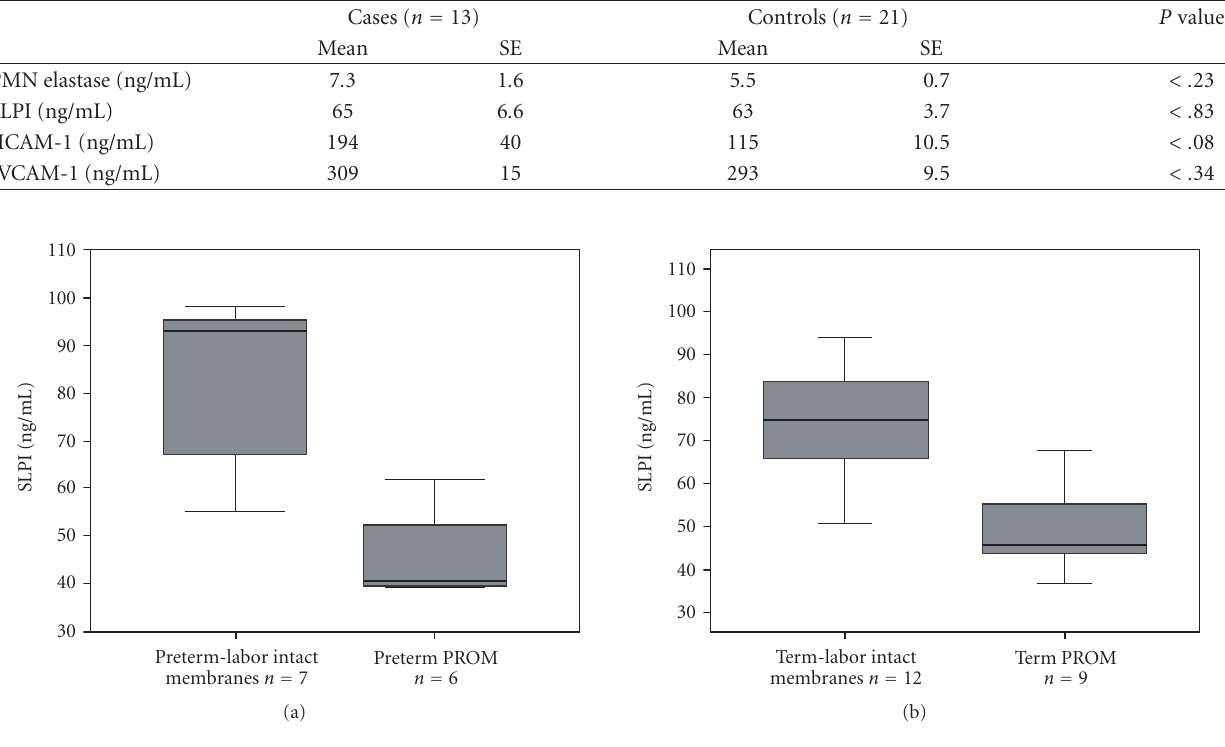
Figure 1: Levels of SLPI in women, who delivered either preterm (a) or at term (b) with intact membranes (a) n = 7 and (b) n = 12 or premature rupture of membranes (PROM) (a) n = 6 and (b) n = 9,